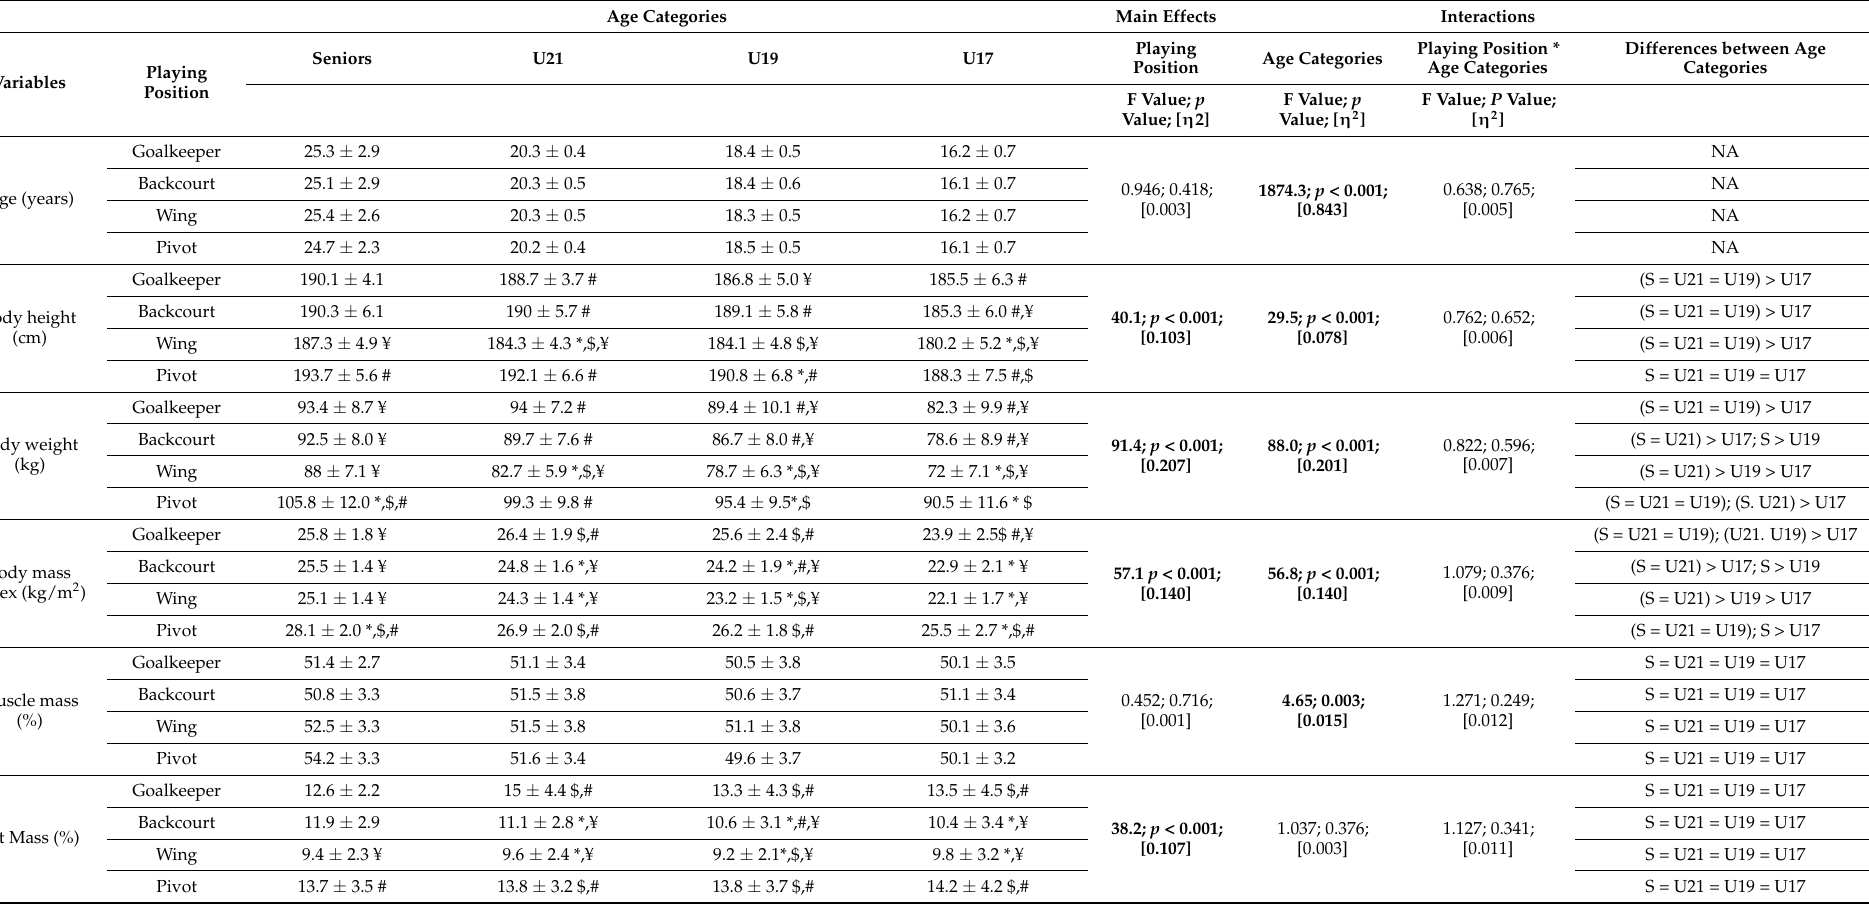
Table 2. The demographic and morphological profile of elite handball players based on age category and playing